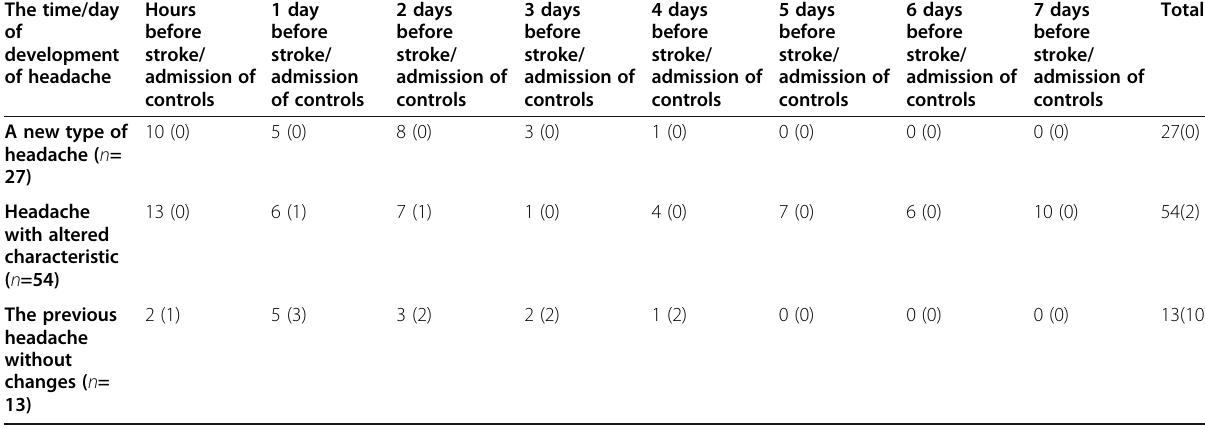
Table 6 The onset of sentinel headache before stroke in relation to the time of stroke or headaches during seven days before admission of the control